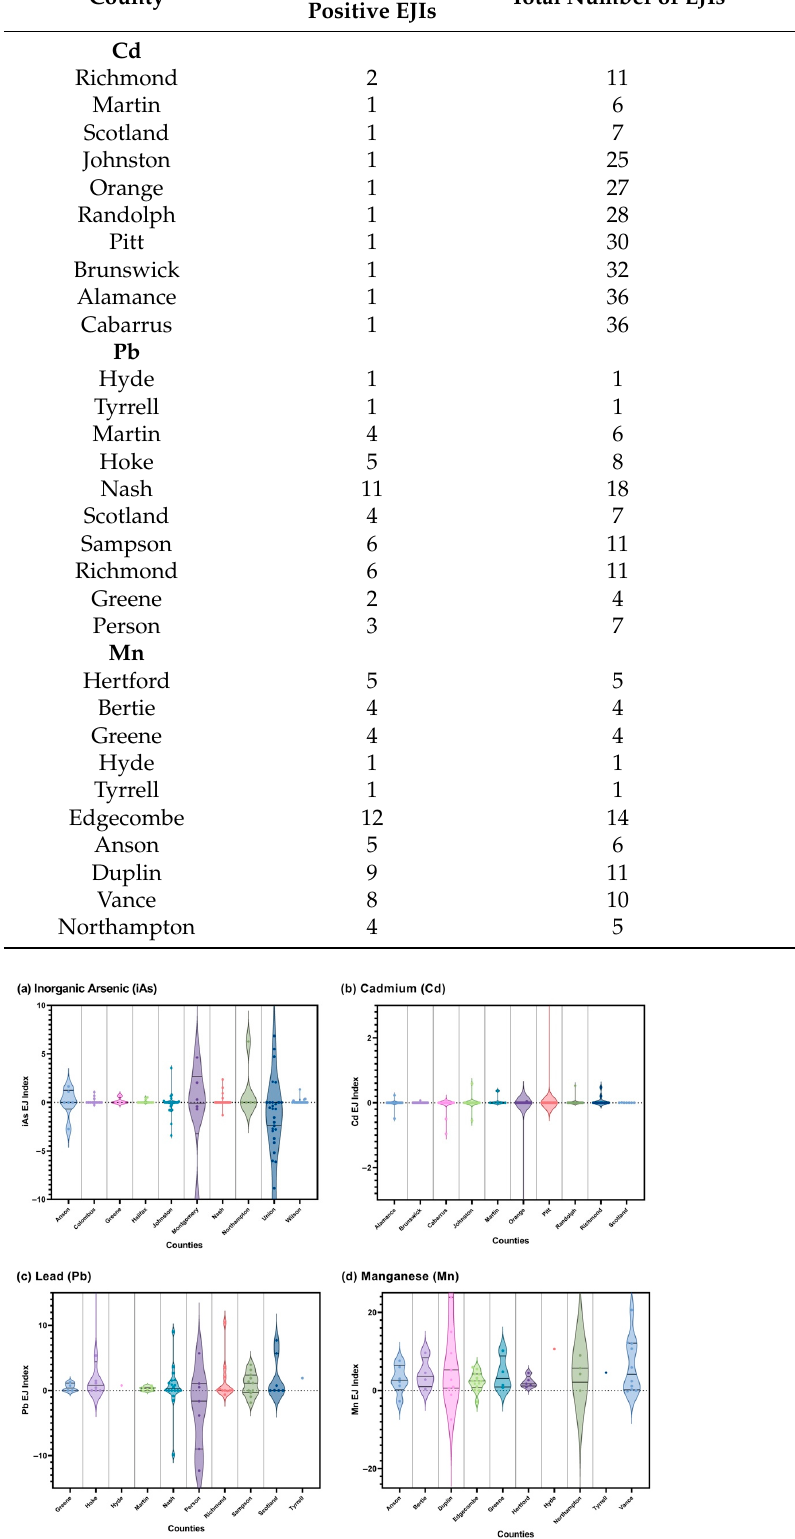
Figure 4. Counties with the highest EJIs for ( a ) inorganic arsenic, ( b ) cadmium, ( c ) lead, and ( d ) manganese contamination of private wells. Positive EJIs represent contamination in disadvantaged areas.